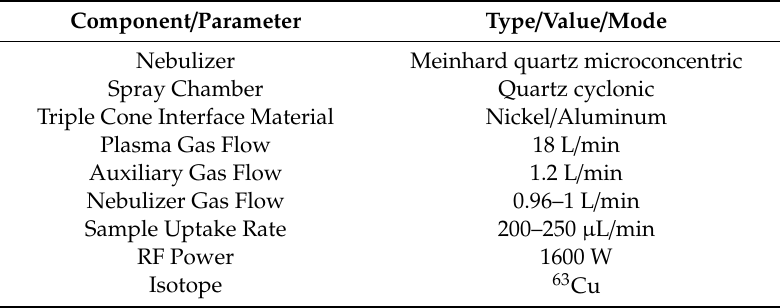
Table 1. Inductively Coupled Plasma Mass Spectrometry (ICP-MS)